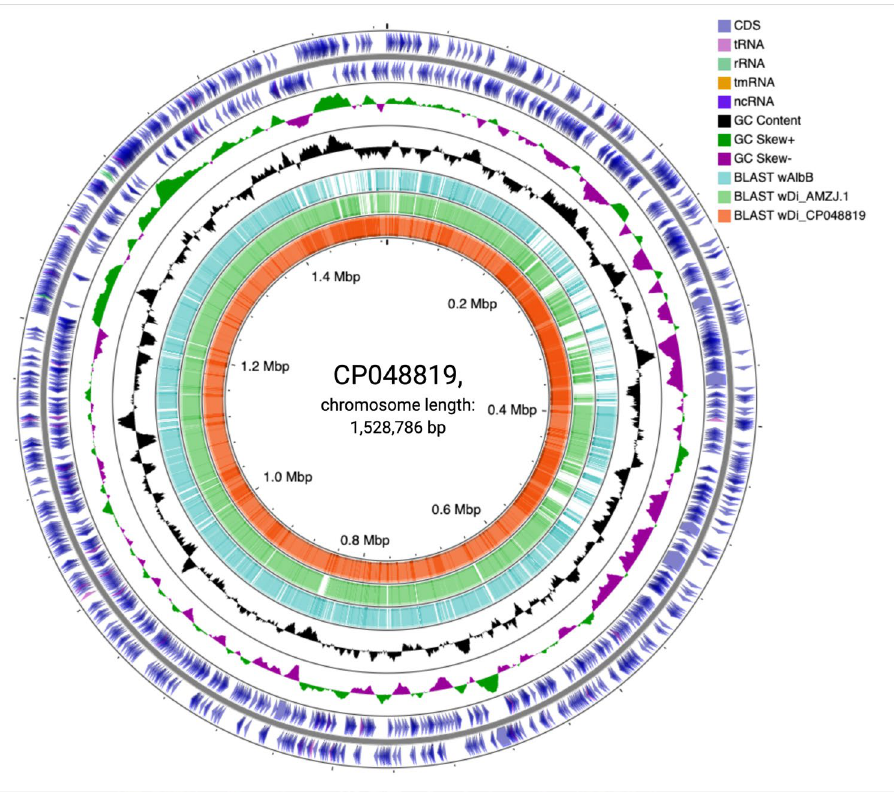
Figure 3. Map of the Wolbachia CP048819 genome prepared using CGView. Circles in order from outer to inner show following parameters: the position of coding sequences (CDS), tRNA, and rRNA genes on the positive and negative strands are denoted by circle 1 and 2, respectively. The circles 3 and 4 show plots of GC content and GC skew plotted as the deviation from the average for the entire sequence. Circles 5–7 show the positions of BLAST hits detected through BLASTn comparisons of w AlbB_CP031221 25 (circle 5), w Di_ AMZJ.1 12 (circle 6), and itself Wolbachia CP048819 (circle